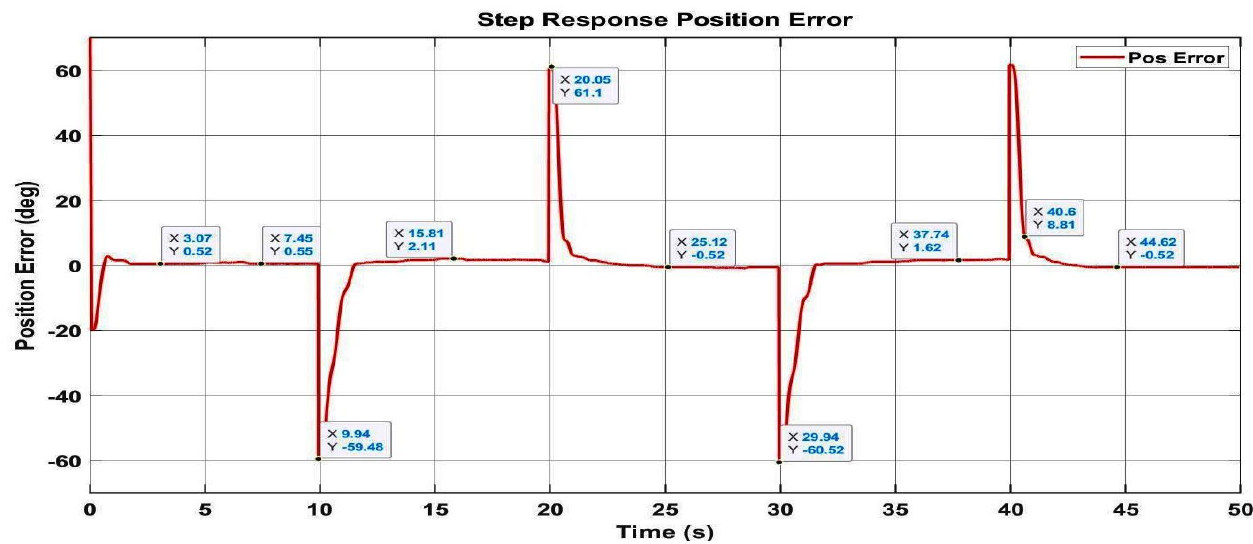
Figure 17. Position error for step response when NARX estimation-based control is active.